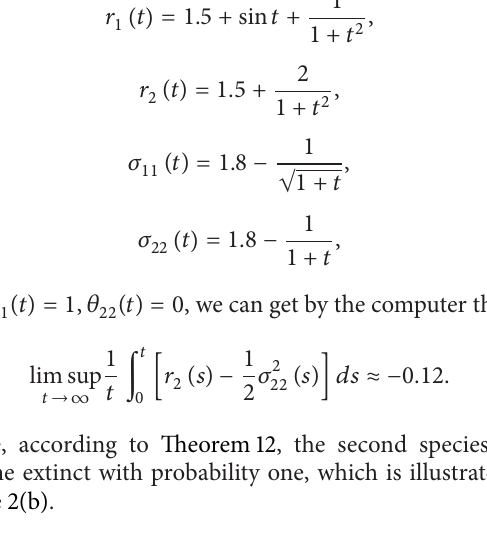
and the rest of parameters are the same as those in Figure